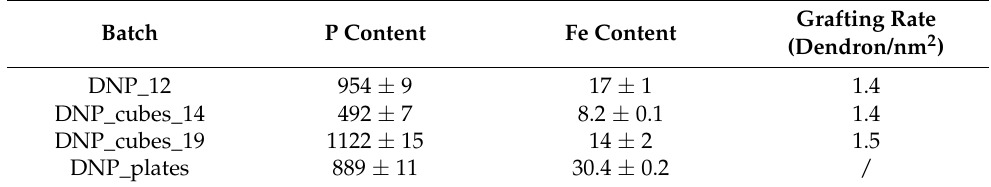
Table 3. Fe and P content evaluated by ICP-AES analysis and the grafting rate of the dendron in the various